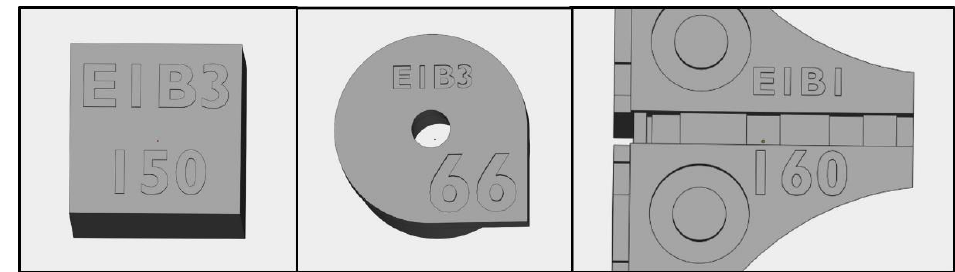
Figure 12. Labeling of additional models where “E1B3” signifies “experiment 1, build 3” and the final number corresponds to the specimen’s number in the current build.